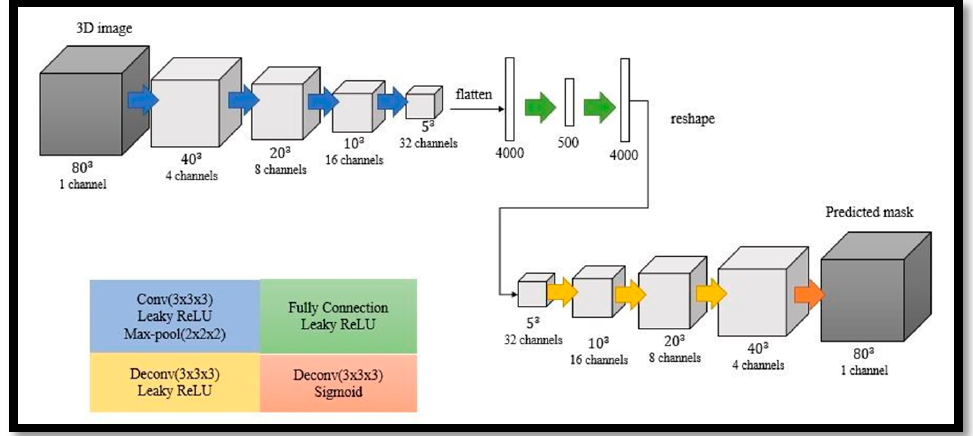
Figure 5. Network architecture of generator.